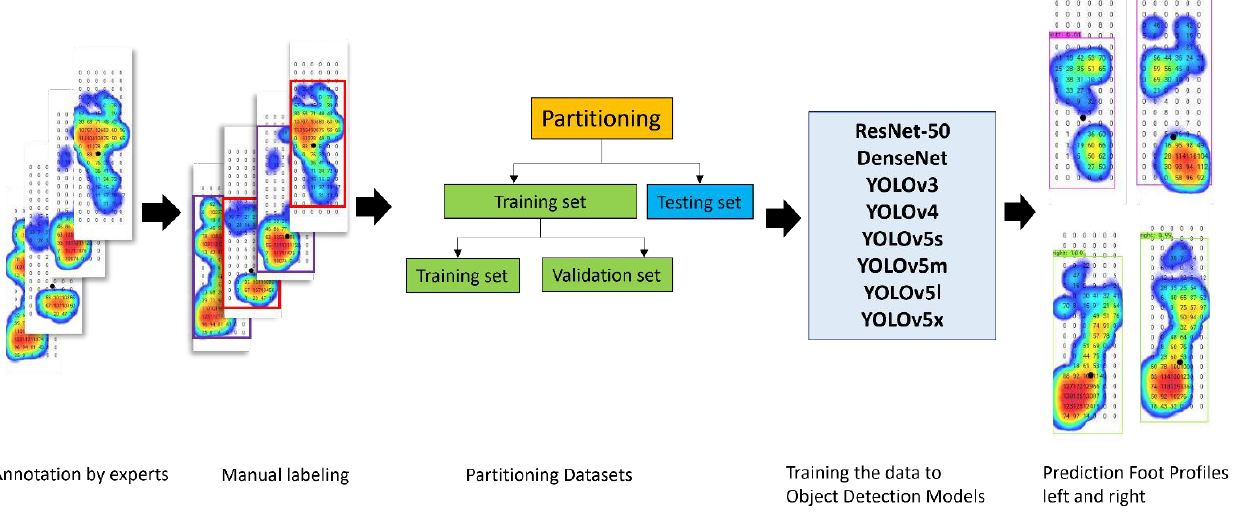
Figure 3. The illustration of foot profile box for left and right feet in plantar pressure image detection with the ResNet-50, DenseNet, YOLOv3, YOLOv4, YOLOv5s, YOLOv5m, YOLOv5l, and YOLOv5x models.